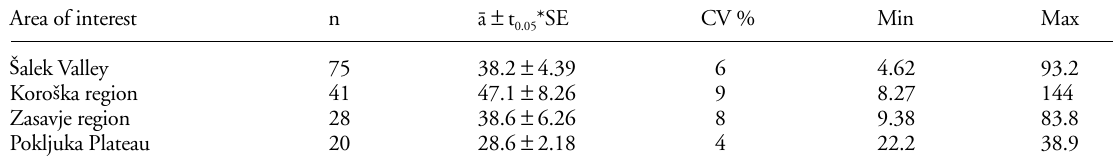
Table 5. Levels of Zn (mg kg –1 wet weight) in kidneys of roe deer shot in some Slovenian regions in 1997. The arithmetic means ( ā ) with the 95% confidence intervals, coefficient of variation (CV %) and range (Min, Max) are given. Area of